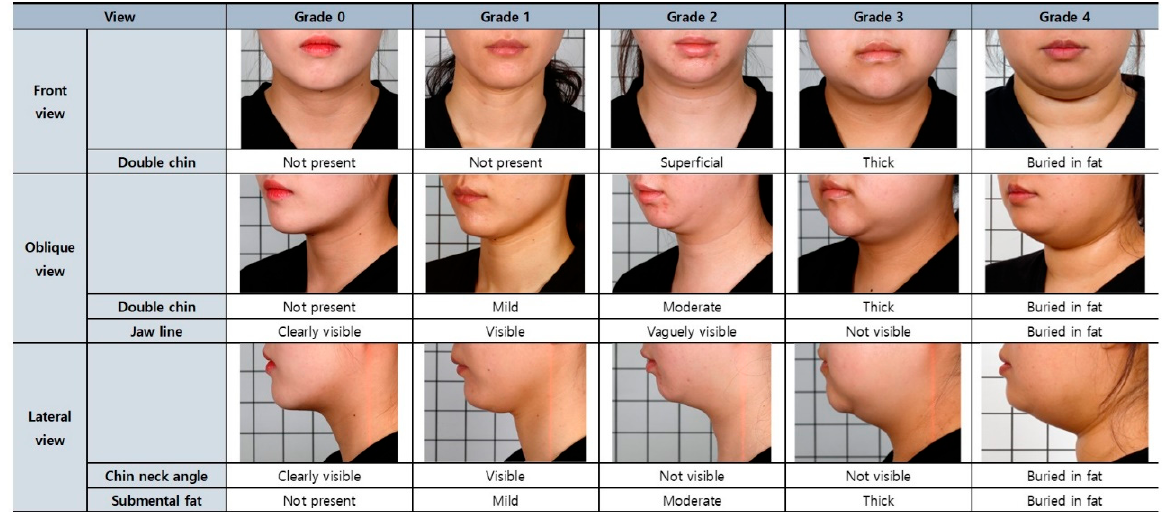
Figure 5. Reference for evaluating submental fat of male subjects.